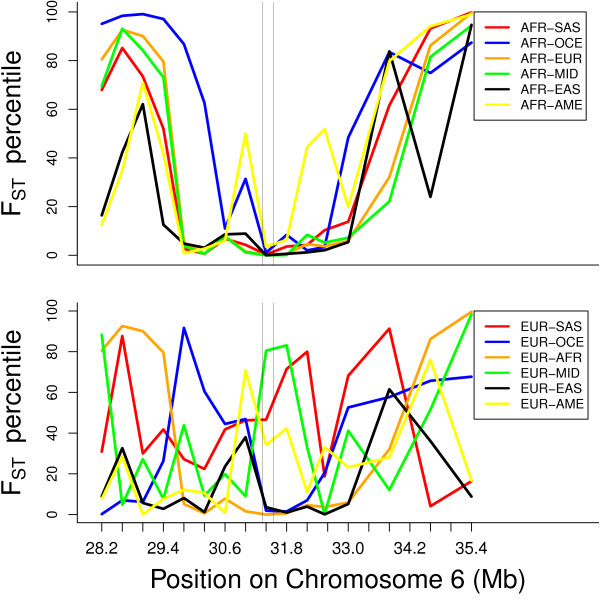
Sliding window analysis of FST percentile for a wider view of the entire HLA region showing that the low FST for AFR doesn't apply everywhere in the HLA but mainly to the region where the HIV associated loci are 31-32 Mb. Vertical lines indicate location of rs2395029 and rs9264942. (AFR: sub-Saharan Africa; MID: Middle East; SAS: South Asia; EUR: Europe; EAS: East Asia; OCE: Oceania; AME: Americas)